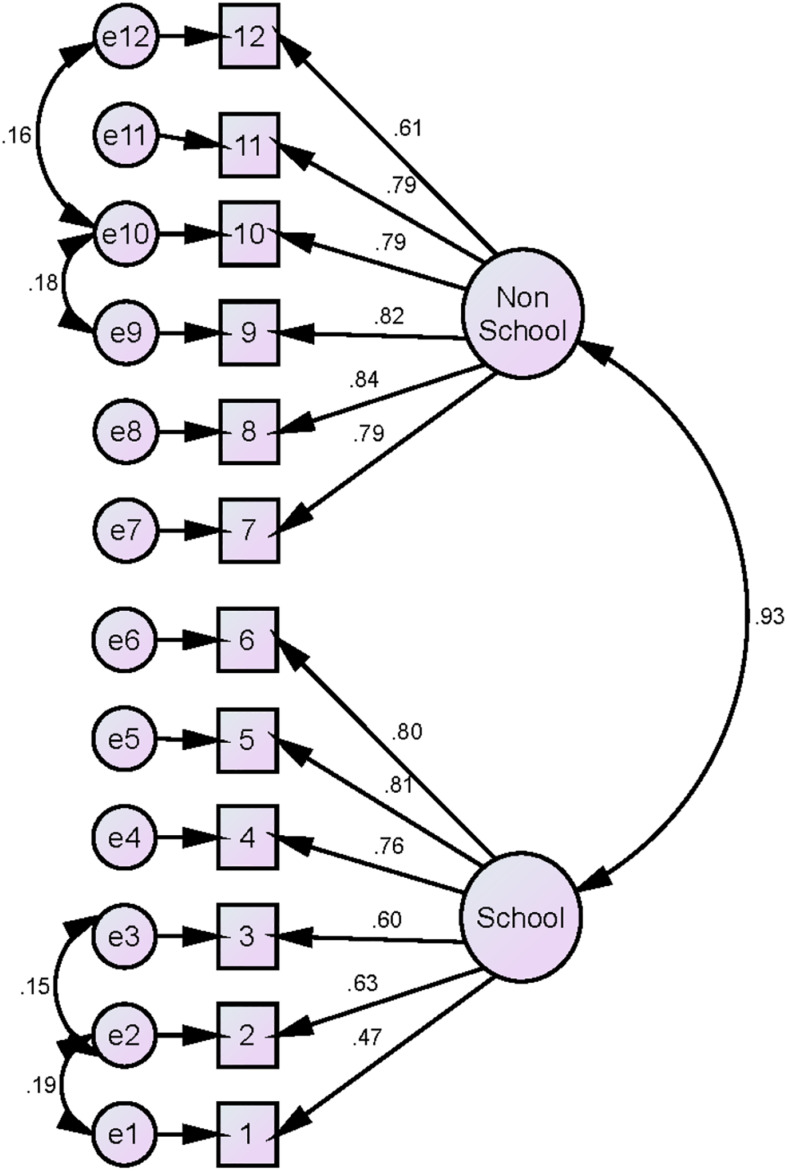
Confirmatory factor analysis of the BIS.